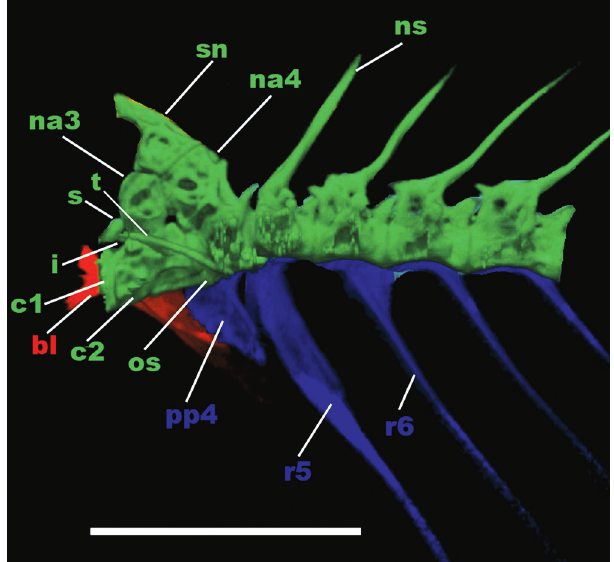
Fig. 8. Weberian apparatus of right side (image reversed) of Iracema caiana (MZUSP 49205, 235 mm SL). Left side ribs and parapophysis removed. Anterior to left. Scale bar is 5 mm. Abbreviations: c1-c2 = centrum; s= scaphium; i = intercalarium; os = os suspensorium; t = tripus; bl = Baudelot’s ligament; na3-na4 = neural arches; sn = supraneural; ns = neural spine; pp4 = parapophysis 4 and r5-r6 =